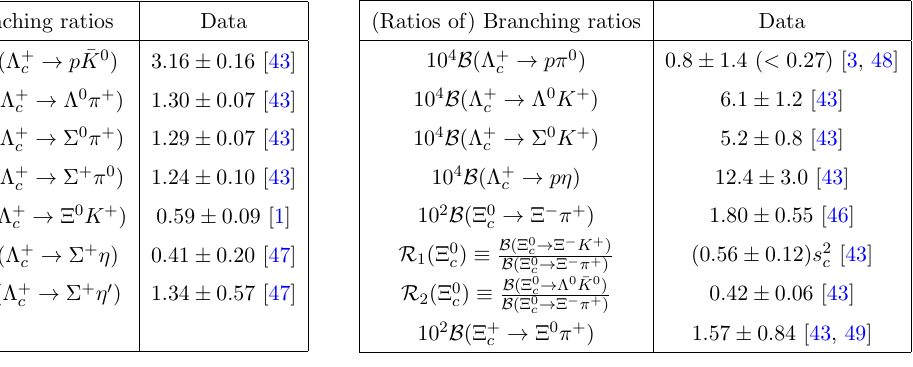
Table 2 . The data for B c